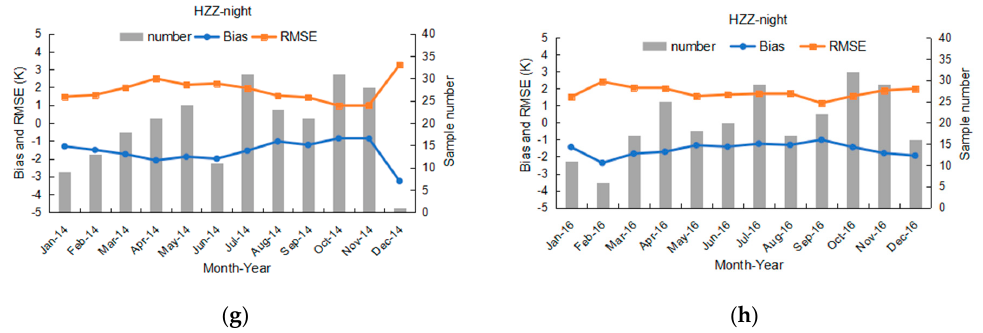
Figure 5. Monthly statistics of rainfall and MODIS LST in 2014 and 2016 at the HZZ site, subplots include ( a ) rainfall, ( c ) all (daytime and nighttime) LSTs, ( e ) daytime LSTs, ( g ) nighttime LSTs in 2014; and ( b ) rainfall, ( d ) all (daytime and nighttime) LSTs, ( f ) daytime LSTs, ( h ) nighttime LSTs in 2016.